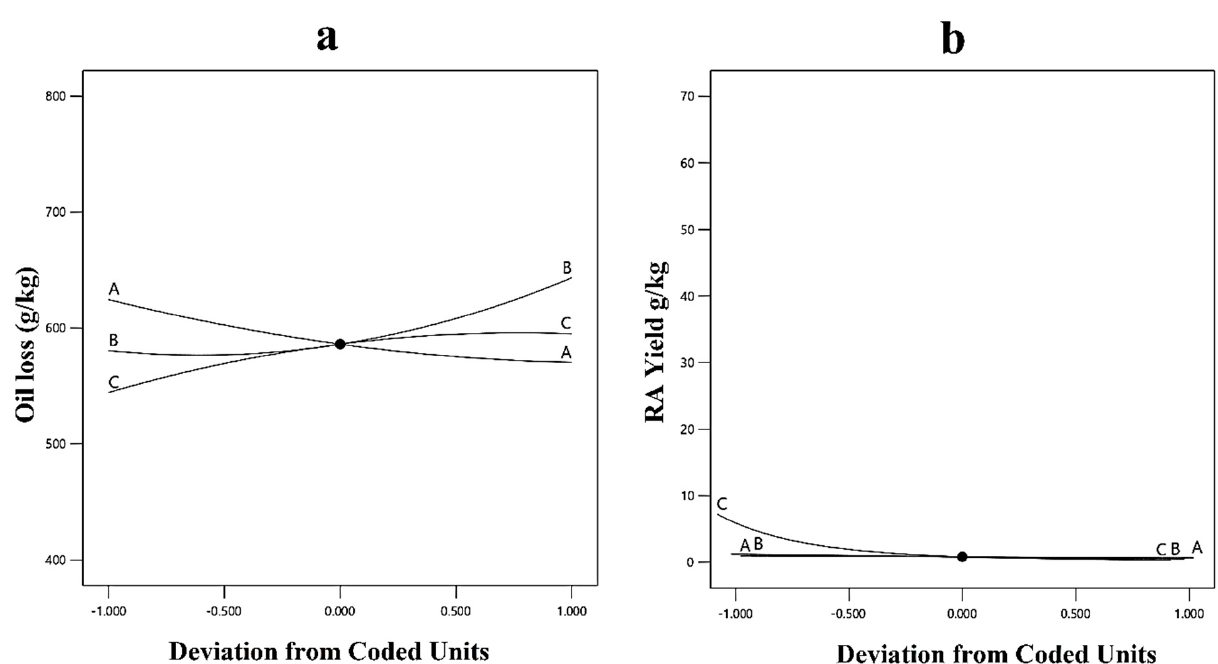
Figure 6. Interaction plots of three independent variables for ( a ) oil loss (g/kg); and ( b ) ricinoleic acid yield (g/kg) where A is the concentration of oil (%), B is glucose concentration (%), and C is the concentration of calcium chloride.